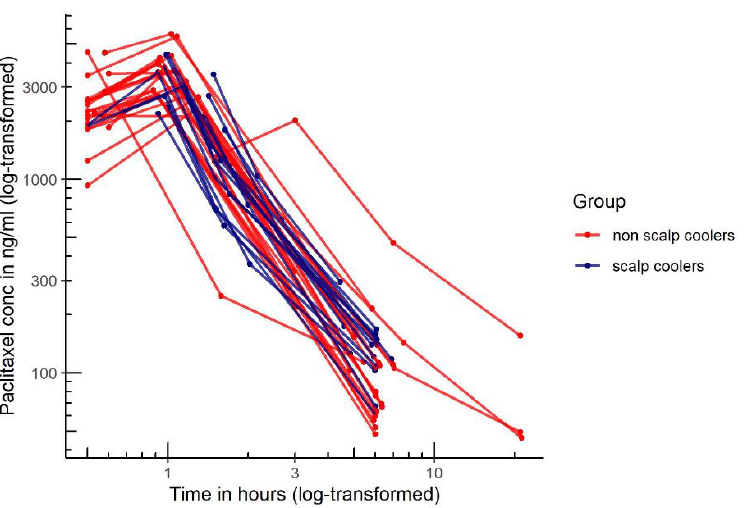
Figure 1. Paclitaxel concentration time profiles of the pharmacokinetic profile of patients using scalp